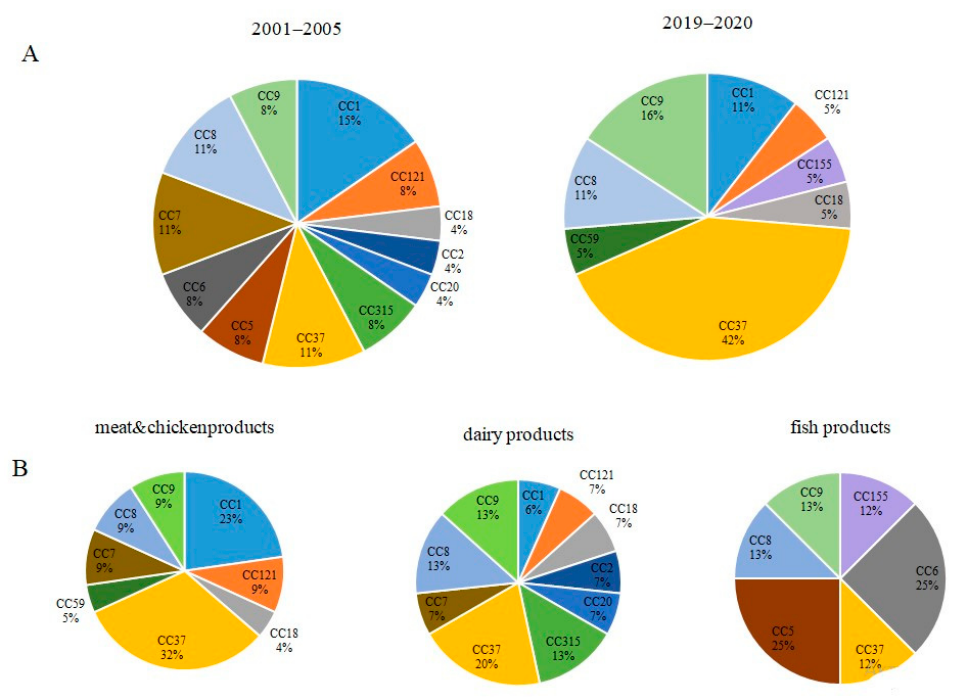
Figure 3. Phylogenetic diversity of studied groups. ( A )—Diversity of strains isolated during 2001– 2005 and 2019–2020. ( B )—Diversity of strains isolated from different food products.